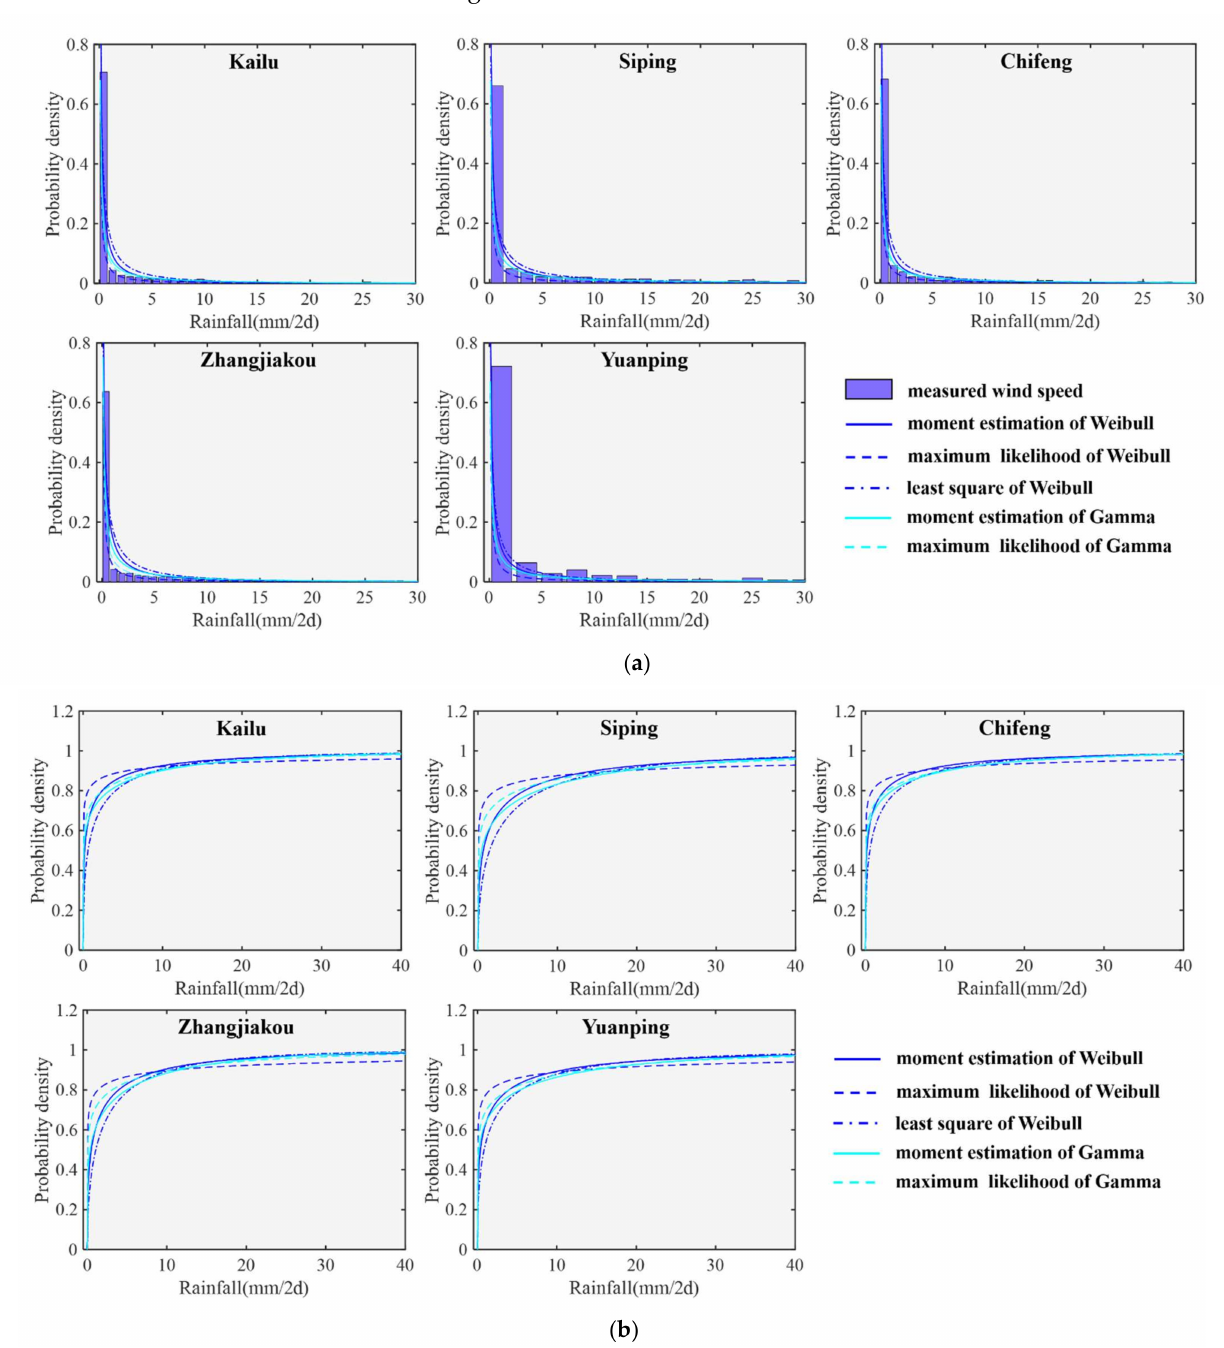
Figure 5. Probability density and probability distribution diagram of precipitation. ( a ) Probability density and ( b ) probability